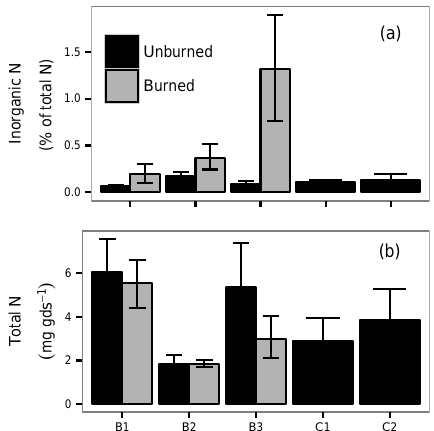
Figure 9. Bar chart showing the pulse of inorganic N relative to the total N pool size. Panel (a) shows the mean percent of inorganic N ) in soil under in unburned and burned periods. (i.e. NH + and NO − 4 3 Panel (b) shows the mean total N soil content in burned and un- burned periods, reported per gram of dry soil (gds). Error bars are ±